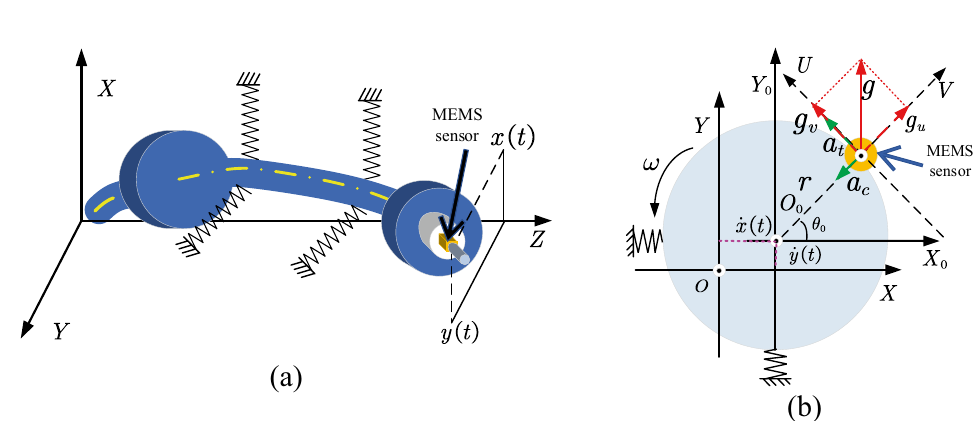
Figure 4. ( a ) Spindle rotor system with the ORS mounted on one end of the workpiece and ( b ) output analysis of the MEMS sensor in the rotor